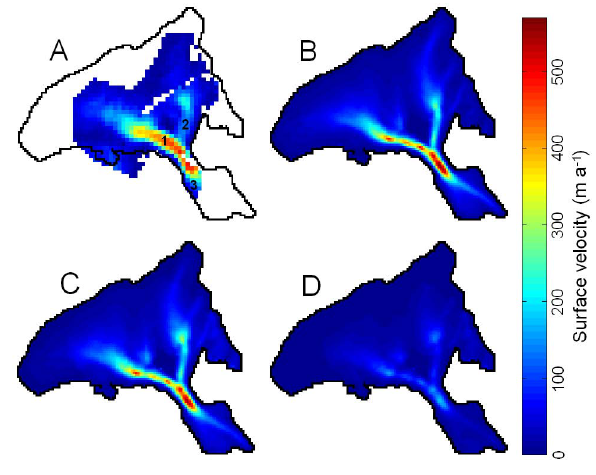
Fig. 7. (A) Late summer ice surface velocity determined by cross- correlation of 2.5m resolution SPOT5 HRG satellite images ac- quired on 27 August and 22 September 2002. The numbers 1–3 point out locations where annual surface velocity signal could be deduced by correlating two SPOT5 HRG satellite images from late September 2002 and 2003 (see Table 2). (B–C) Depth–averaged modeled ice velocity corresponding to the simulated 2002 ice sur- face geometry, using A =6.8 × 10 − 15 s − 1 kPa − 3 implicitly includ- ing the basal sliding (in B ), and using A =4.6 × 10 − 15 s − 1 kPa − 3 and C =10 × 10 − 15 ma − 1 Pa − 3 (in (C) ). (D) The contribution of the modeled basal sliding to the velocity shown in (C) . Table 2. Average annual (September 2002 to September 2003;